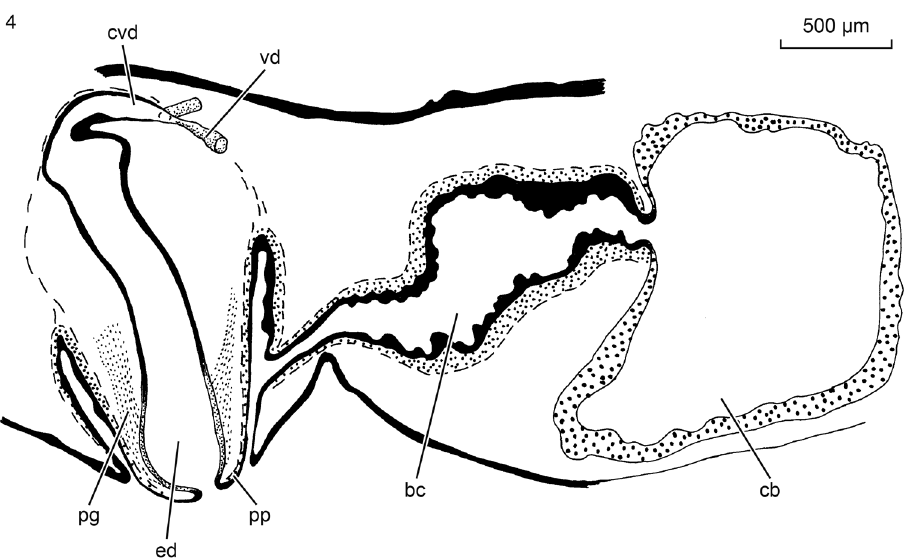
Figure 4. Paucumara trigonocephala . ZMA V.Pl. 7279.1, sagittal reconstruction of the copulatory ap- paratus; anterior to